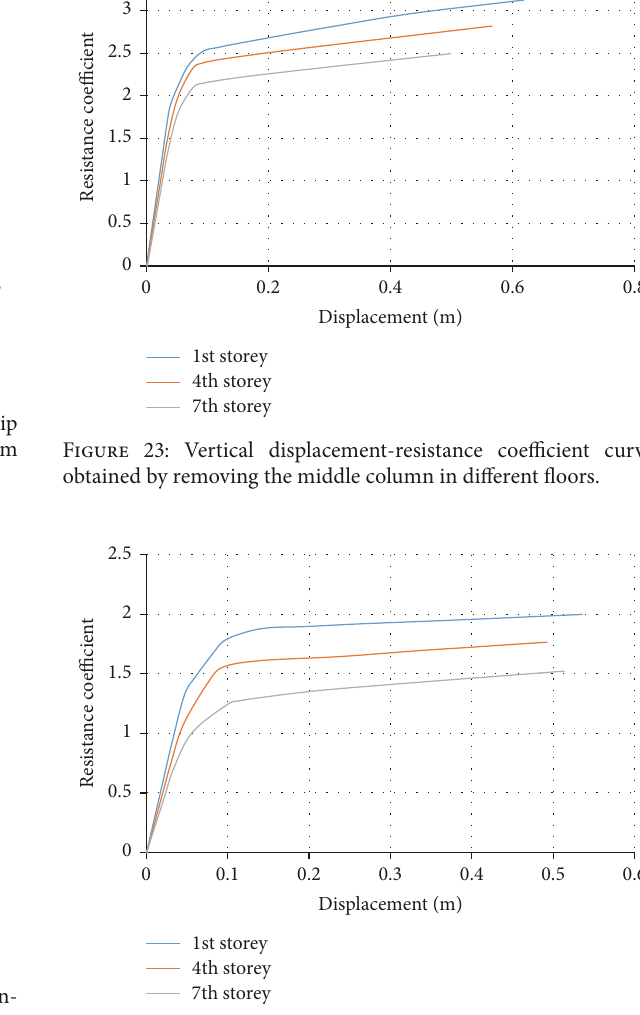
Figure 24: Vertical displacement-resistance coefficient curves obtained by removing the corner column in different